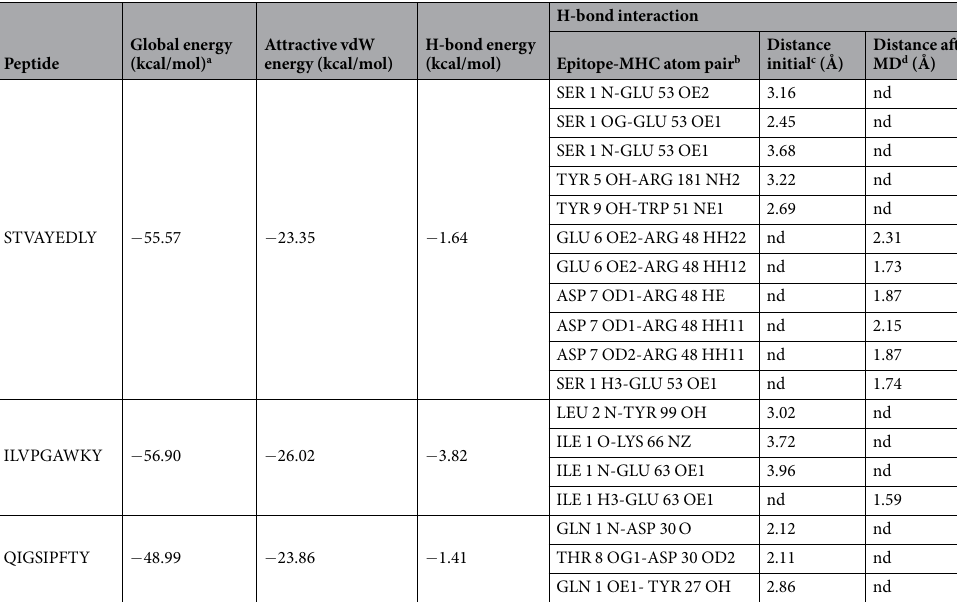
Table 8. CTL epitopes and HLA-A * 0201 interactions. a FireDock energy for the best ranked complex. b Interacting pair of atoms and residues between epitope and HLA-A * 0201. c Initial distance between the H-bond acceptor and the donor. d Distance between the H-bond acceptor and the donor after the MD simulation. nd = H-bond not